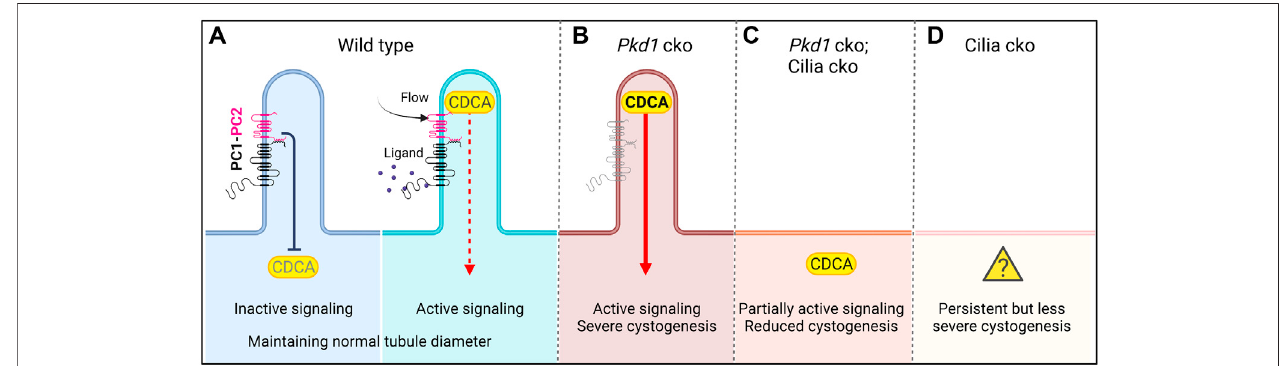
FIGURE 2 | Cilia-dependent cyst activation (CDCA) model for cystogenesis in ADPKD (adapted from Ma, 2021). (A) The CDCA in the wild-type cell is suppressed bypolycystinsandisactivatedthroughanunknownmechanism,possiblyligandbindingtopolycystinsor fl owbendingthecilium. (B) In Pkd1 cko,CDCAisderepressed and constitutively activated leading to severe cystogenesis. (C) If Pkd1 and cilia are co-ablated, the CDCA cannot be upregulated. The cystogenic signal is thus diminishedcomparedwithsingle Pkd1 cko,resultinginreducedcystogenesis. Inthismodel,theCDCAsignalmustretainapartial “ leaky ” functioninthecytoplasm toexplainhow Pkd1 -ciliadoublemutantsdisplaysigni fi cantcysticchanges. (D) Inciliasinglemutants,thereispersistentmildcystogenesis.HeretheCDCAmusthavea leaky function despite the presence of intact polycystins and lack of cilia ( “ ? ” ). Created in